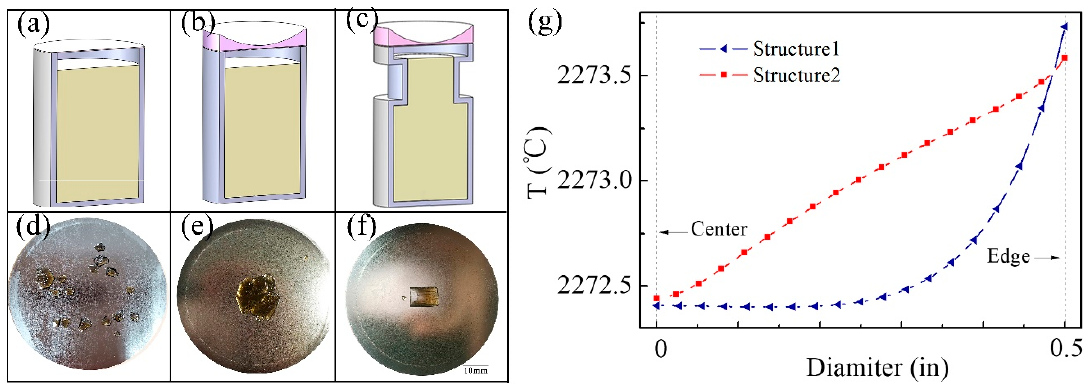
Figure 7. ( a ) The schematic diagram of traditional crucible (structure 1); ( b ) The schematic diagram of crucible with adjusted radial temperature gradient (structure 2); ( c ) The schematic diagram of crucible with adjusted radial temperature gradient and supersaturation (structure 3); ( d – f ) The experimental results from three different crucible structure; ( g ) Comparison of radial temperature distribution of the substrate between structure 1 and structure 2.